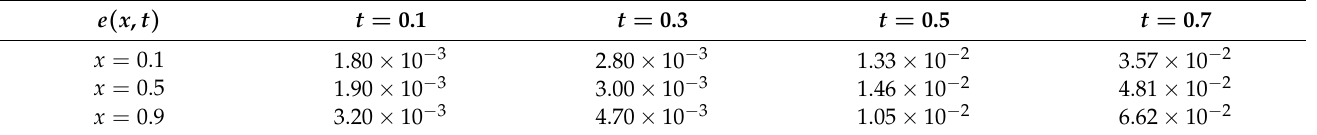
Table 4. Absolute error of each point when α = 1.